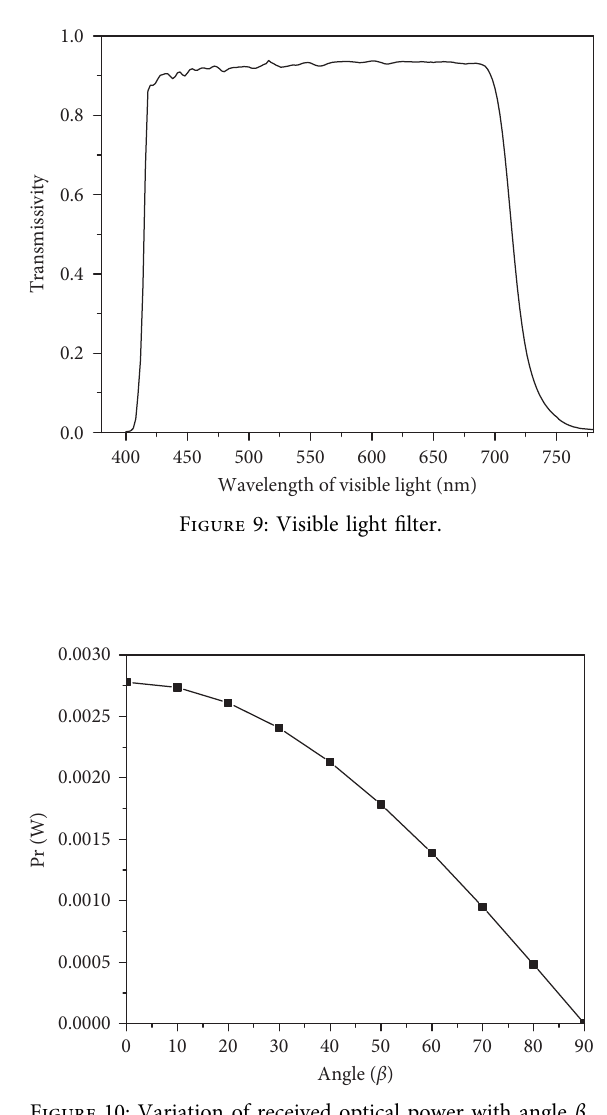
Figure 10: Variation of received optical power with angle β.